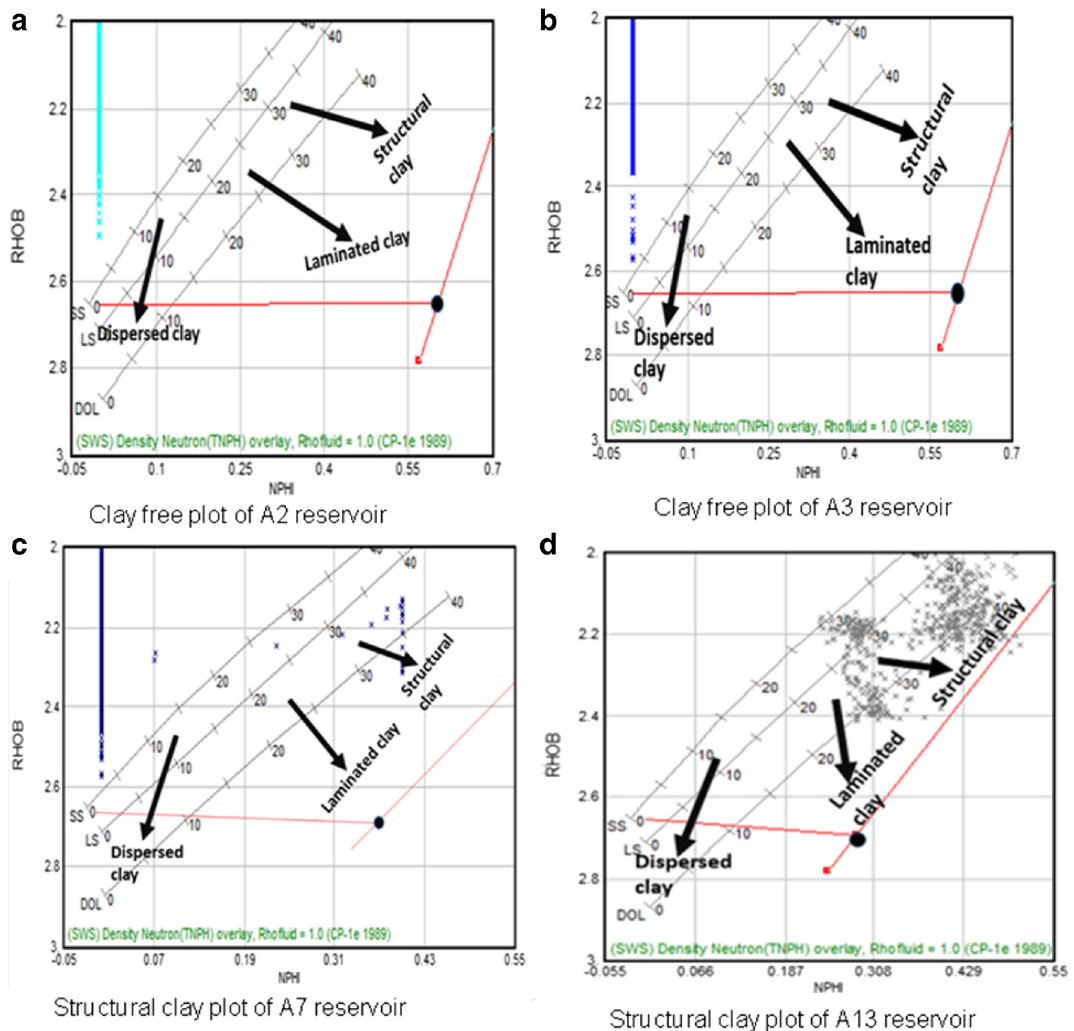
Fig. 10 Neutron–density crossplot model showing the clay distributions in the reservoirs a A2, b A3, c A7 and d A13 of JAP- 1